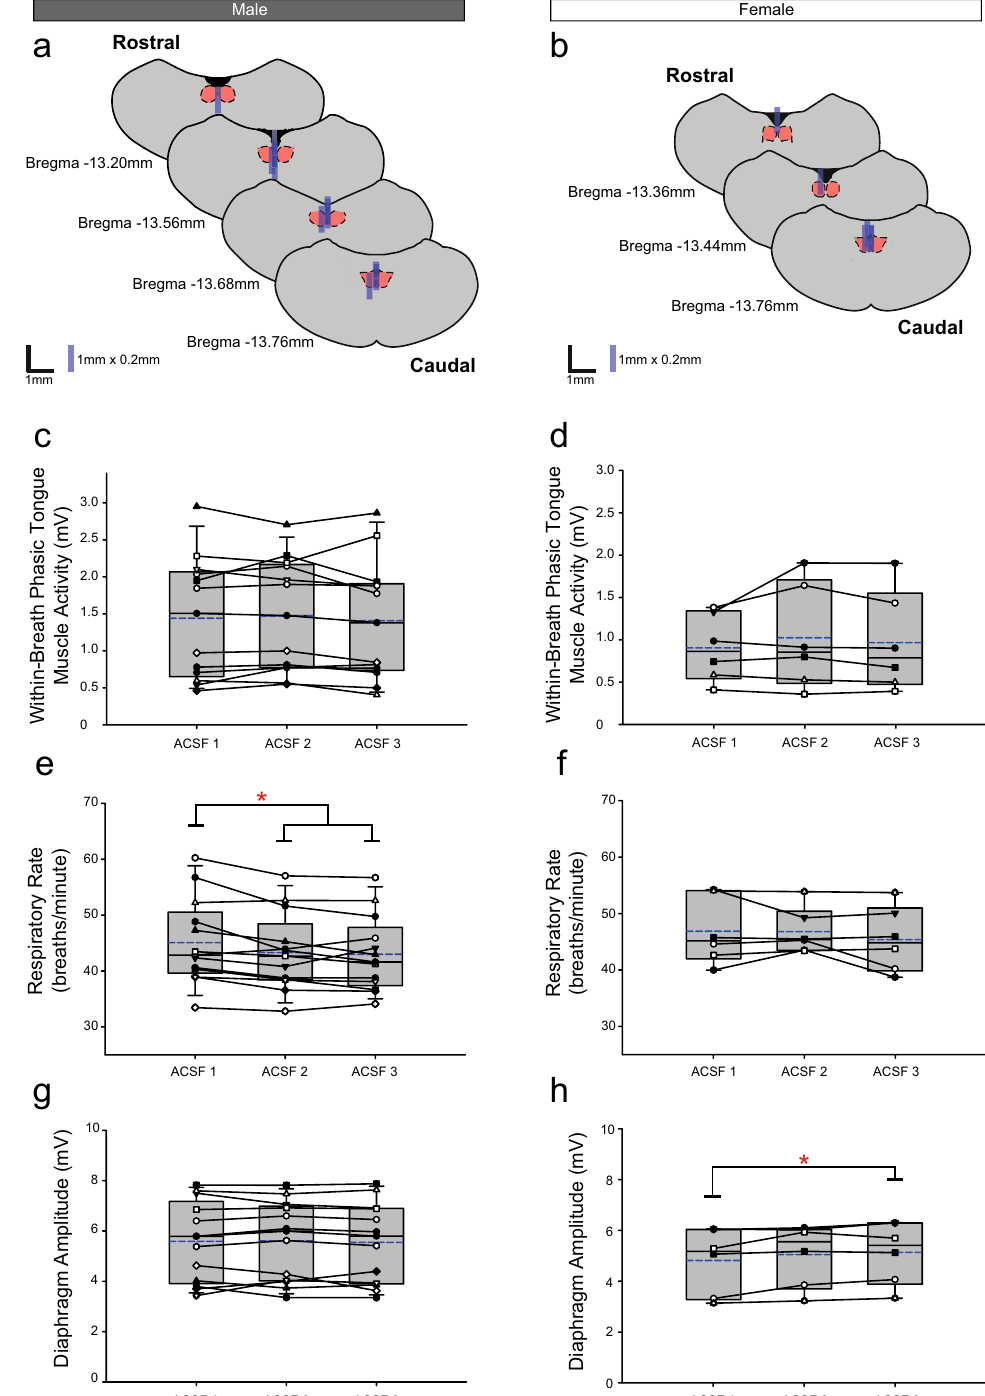
Figure 7. Group data from Protocol 2 : Effects of sequential ACSF (i.e., sham) time-control interventions at the HMN (left column: male, n = 13; right column: female, n = 6). Schematic representations of coronal sections of medulla illustrating the distribution of probe sites across all experiments ( a , b ). Drawn to scale, the blue rectangles represent reconstruction of the sites of the microdialysis probes; overlap obscures some of the individual probe sites. Box and whisker plots show individual and group data (median [dashed line], mean [solid line] and 25th and 75th percentiles) for within-breath phasic tongue muscle activity ( c , d ), respiratory rate ( e , f ), and diaphragm amplitude ( g , h ). Each animal is indicated by a different symbol. *, indicates p < 0.05 compared to baseline ACSF